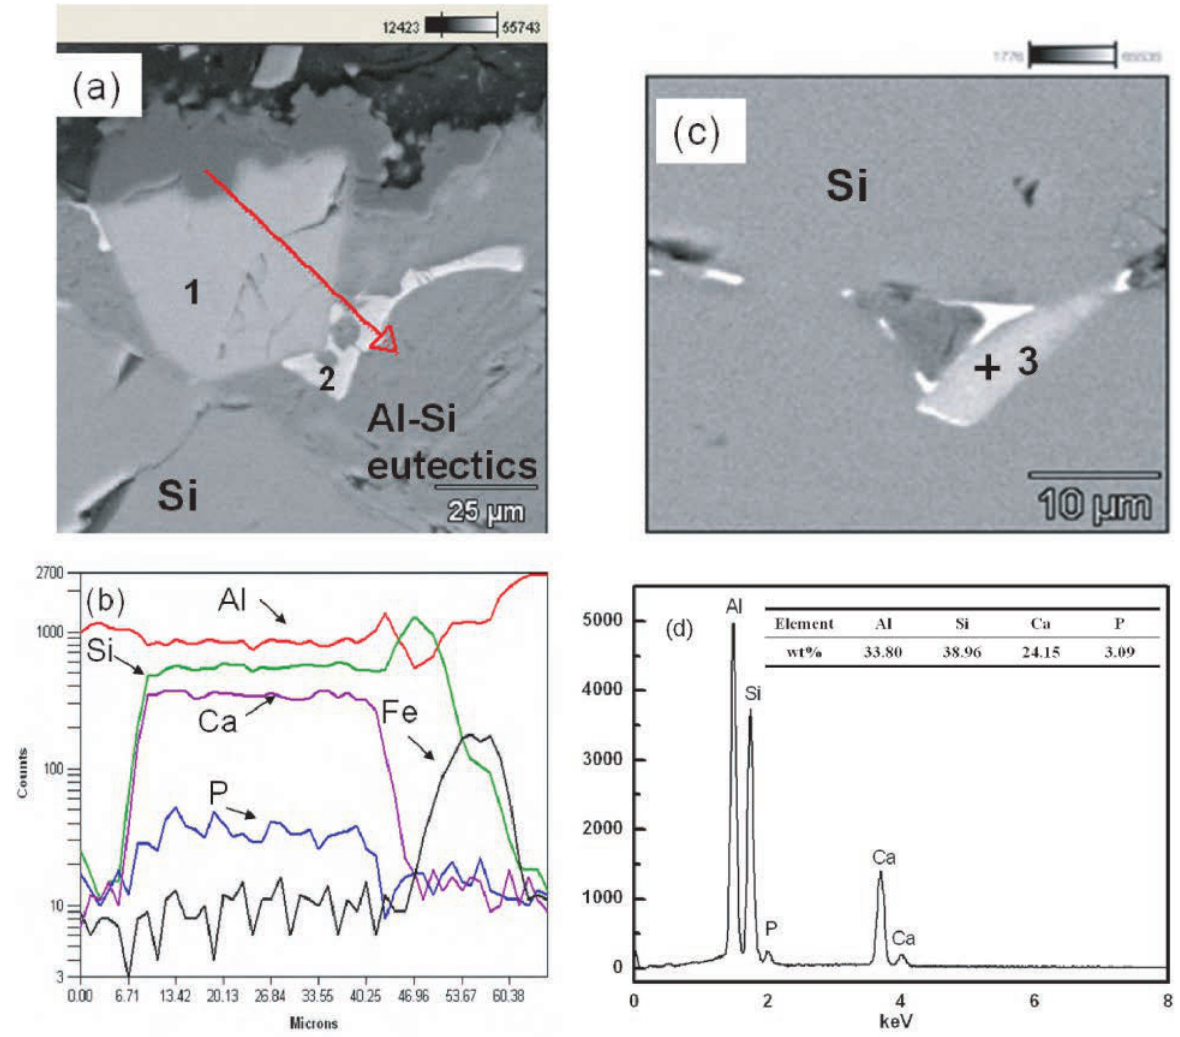
Fig. 7: (a) SEM image of recrystallized Si; (b) EDS line scan of impurity phases in (a); (c) SEM image of refined-Si; (d) EDS result corresponding to point 1 in